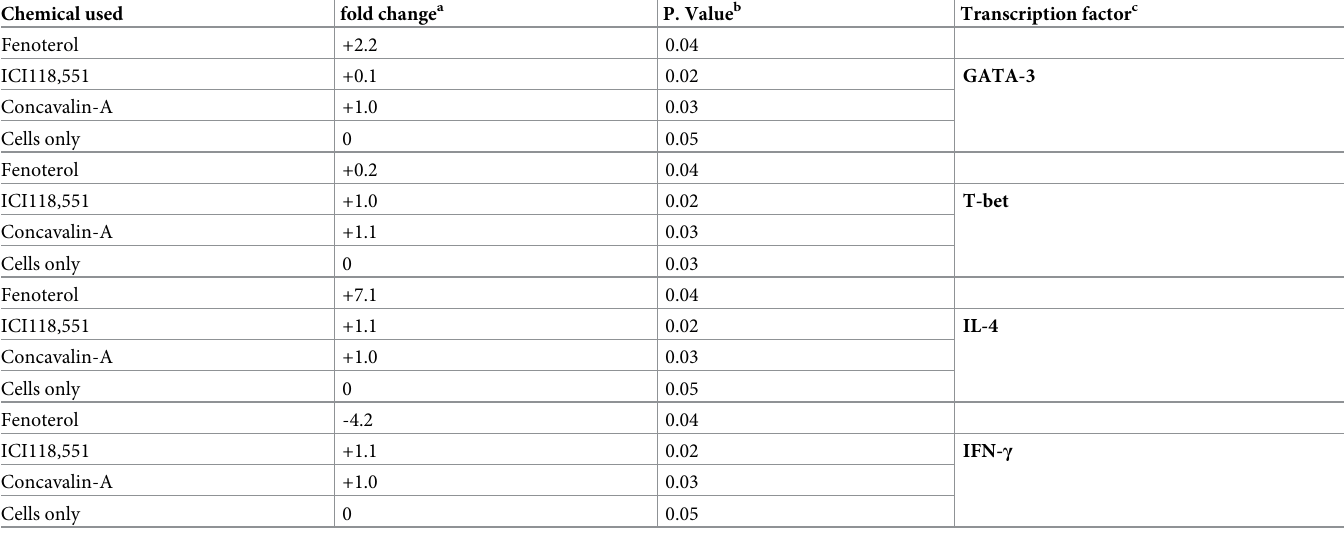
Table 3. Impact of b2—AR agonist or b2-AR antagonist on gene expression of signature cytokines of Th1 and Th2 cells during C . muridarum genital infection of a murine stress model. Chemical